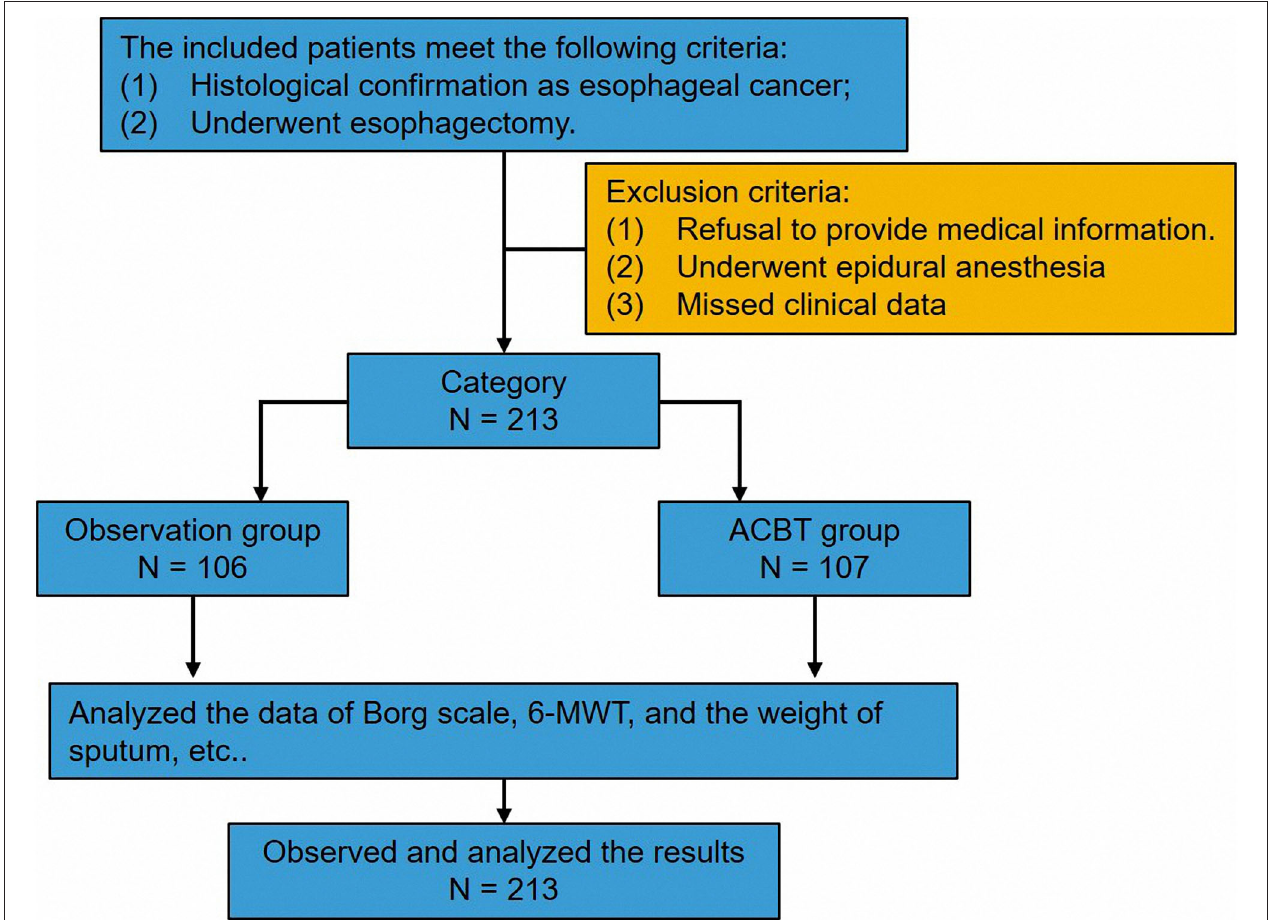
FIGURE 1 | The follow chart of this